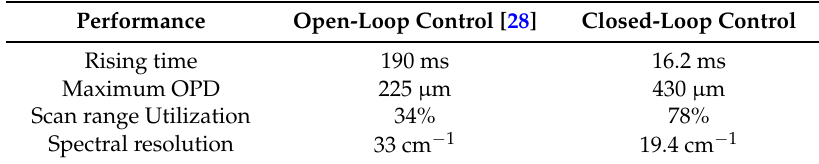
Figure 11. The recovered spectrogram of the test light by FFT. Table 3. The comparison between the open-loop and closed-loop control.